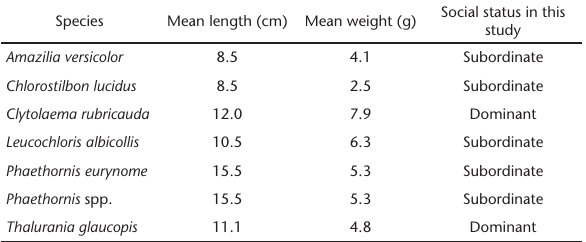
Table 2. Average lengths (with tails and bills included) and weights of the hummingbird species recorded at Itacolomi State Park, Ouro Preto, according to Sick (1997) and Dunning-Junior (2008).